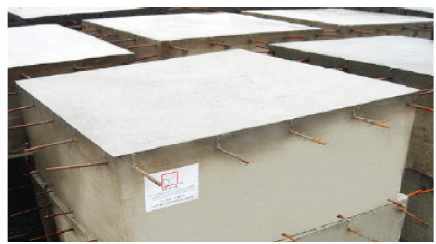
Figure 1: Prefabricated box of hollow